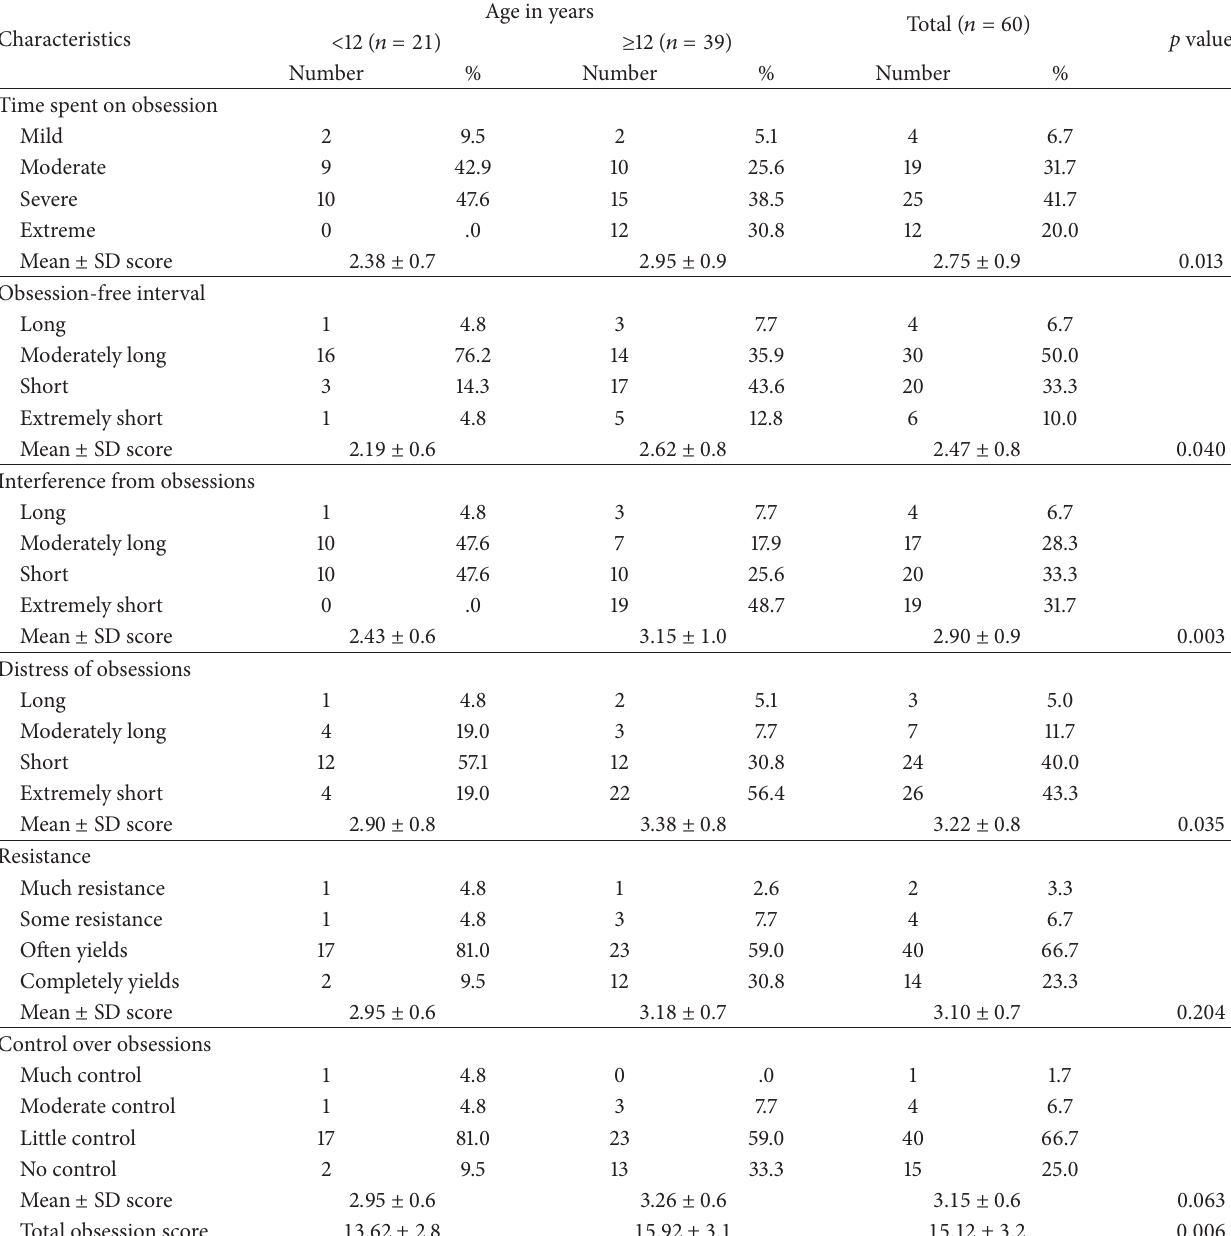
Table 2: Characteristics feature of obsession according to Children’s Yale-Brown Obsessive